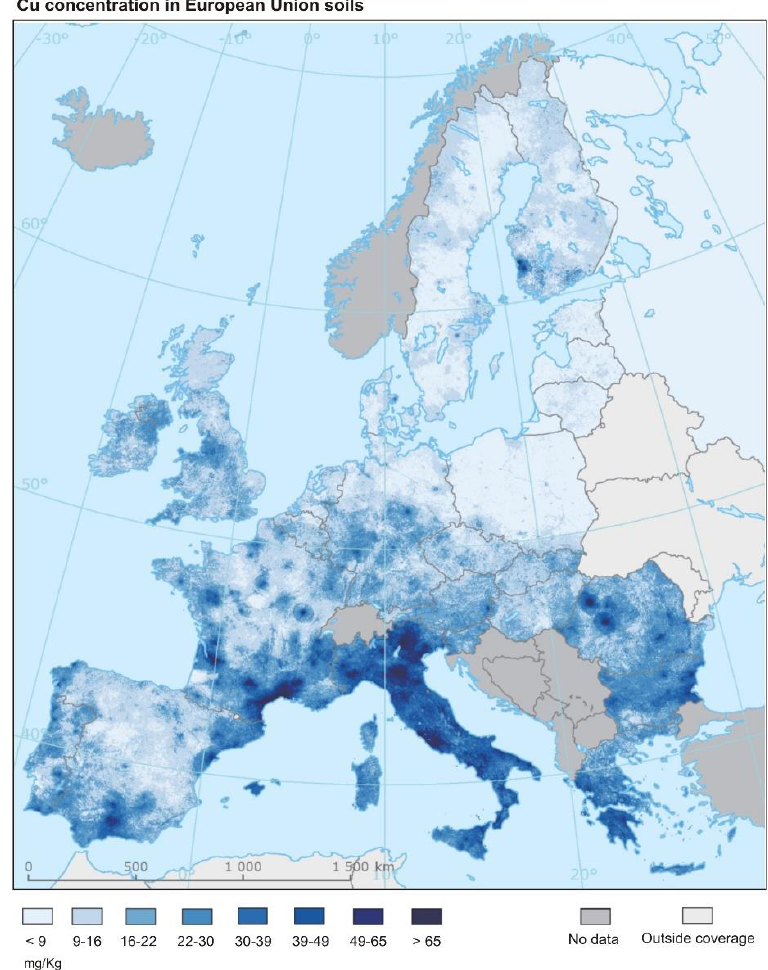
Figure 2. Copper concentration in European Union soils (adapted from [33]).